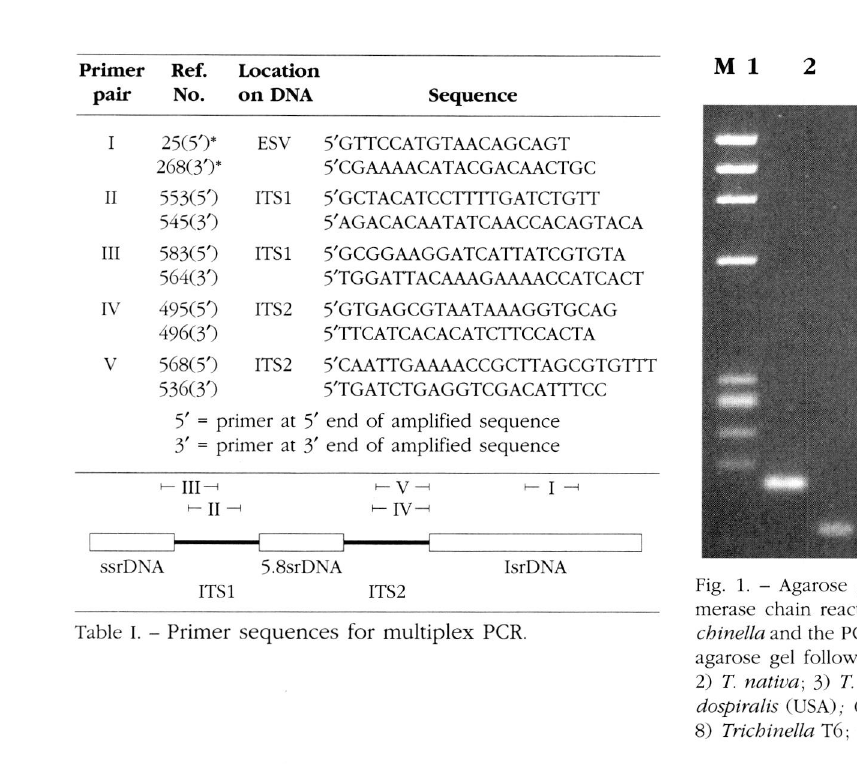
Genomic DNA (1 ng) from each Trichinella genotype